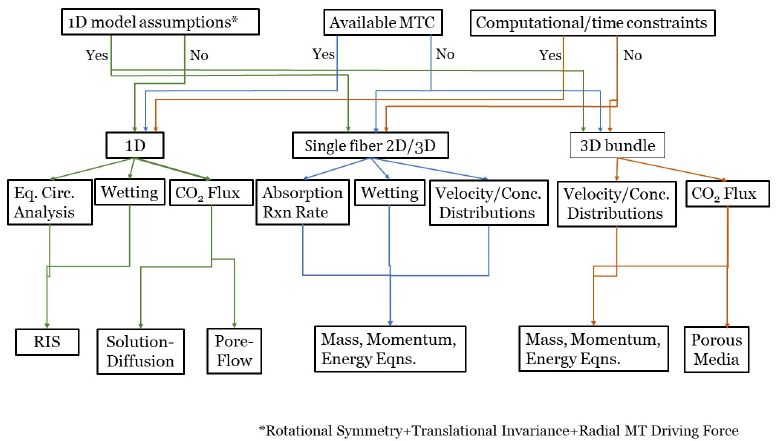
Figure 10. The road map is separated based on three defining questions: (1) Is the modeler taking into account 1D model assumptions? (2) Does the modeler have access to the mass transfer coefficient values? (3) Does the modeler have computational or time constraints? Depending on those qualifications, 1D, 2D, or 3D models can be chosen. Each modeling approach previously described for 1D, 2D, and 3D models provide specific end goal phenomena to be described. These goals for 1D models shown here are solving for the equivalent circuit analysis (eq. circ. analysis), the wetting effects, and CO 2 flux removal. Depending on the overall goal, the RIS, solution-diffusion or pore flow model could be used. For 2D axisymmetric/3D single fiber models, the end goal could consist of observing the absorption reaction rate, the wetting effects and overall velocity and CO 2 concentration profiles. The mass, momentum and energy equations could be coupled to recover the velocity and concentration profiles in all three domains (tube, membrane, and shell domains). Finally, 3D models observe the overall bundle of the HFMC. If the final goal is to determine detailed fluid and concentration distributions within the bundle, the mass, momentum and energy equations should be used for more accurate results. However, if the overall goal is to observe the CO 2 flux rate, the porous media approach should work just as